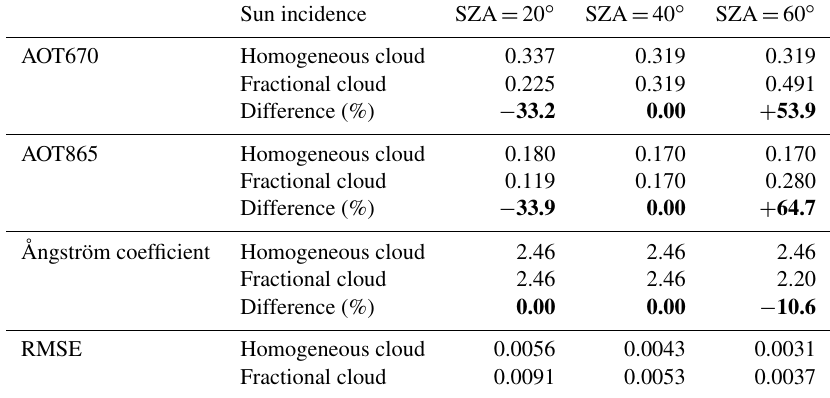
Table 3. Retrieved aerosol properties for a biomass aerosol layer above the fractional cloud with the operational algorithm described in Waquet et al. (2013a). Aerosol optical thickness at 670nm (AOT670), at 865nm (AOT865) and Ångström coefficient for three solar zenith angles (SZA). Relative differences [(Fractional − Homogeneous) / Homogeneous × 100] are indicated in bold. Last two lines, RMSE com- puted between the input and the recalculated polarized reflectances for the homogenous and fractional cloud. Sun incidence SZA = 20 ◦ SZA = 40 ◦ SZA = 60 ◦ AOT670 Homogeneous cloud 0.337 Fractional cloud Difference (%)